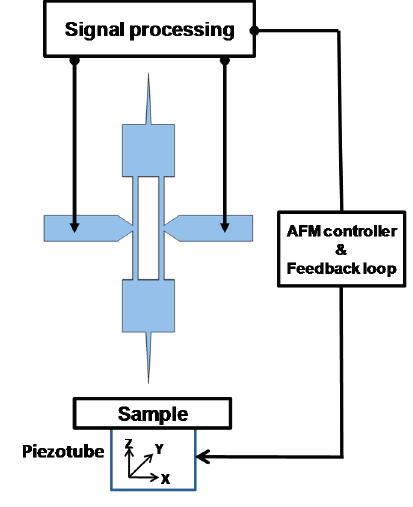
Figure 2. Working principle of AFM microscopy using a dog-bone